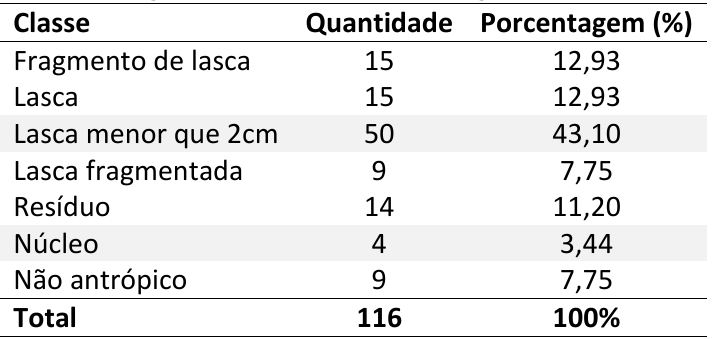
Table 3. Abrigo do Alvo identified lithics